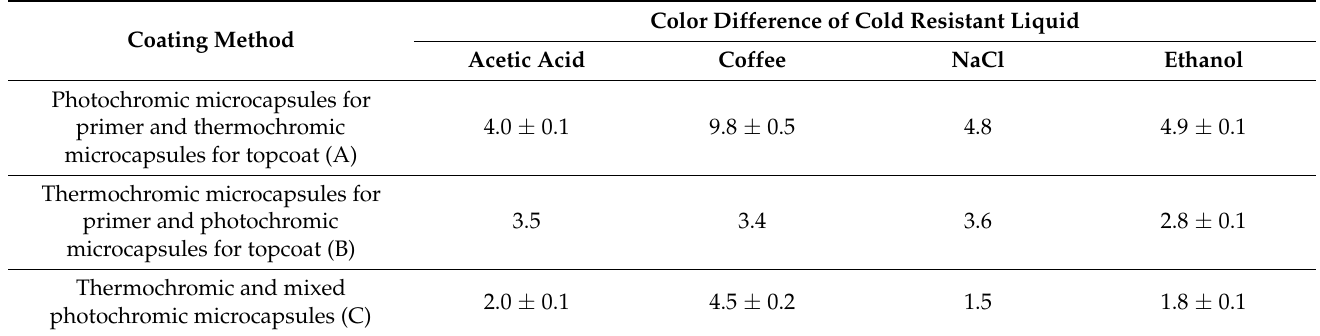
Table 9. Color difference of coating after cold liquid resistance under different coating processes.